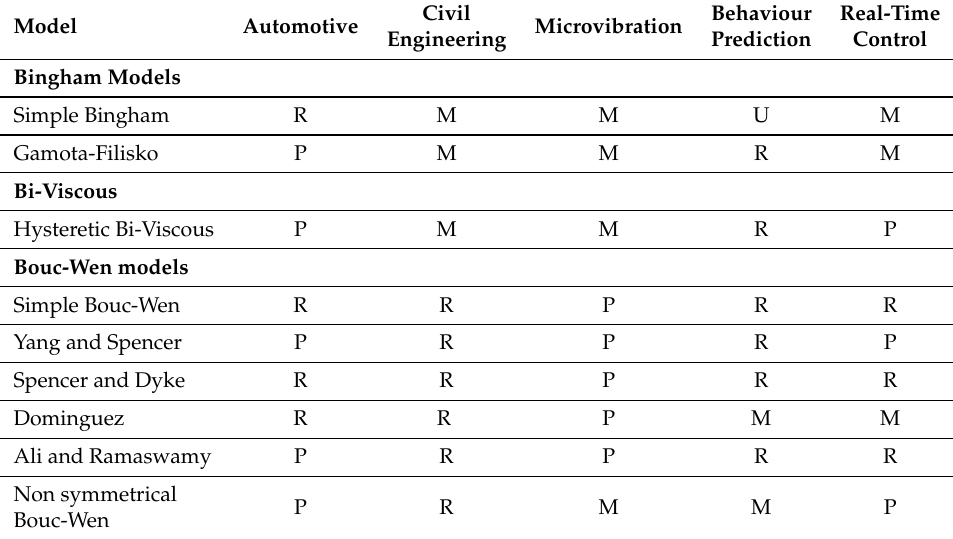
Table 6. Major applications of parametric dynamic models for MR dampers. Key: R = Recommended, U = Unfeasible, M = Request further research, P =